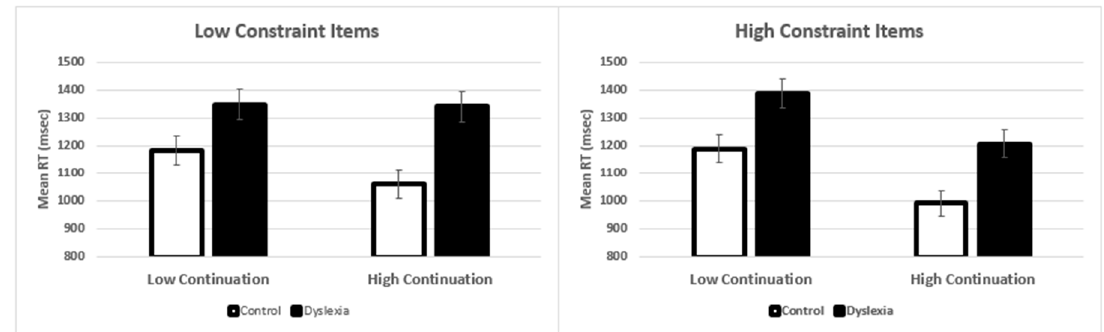
Figure 2. Gender adjusted mean reaction times. Left panel shows the results for the low-constraint items and the right panel shows the high-constraint items. Error bars show the standard error of the mean.